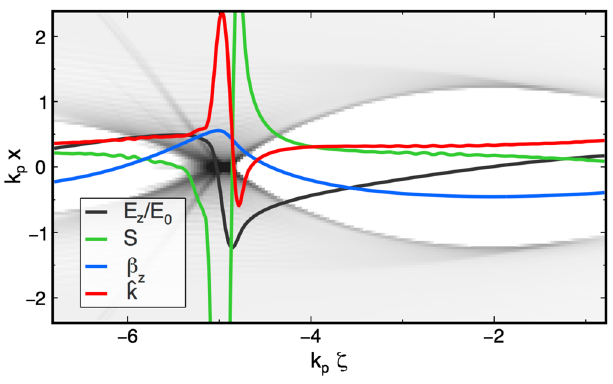
12. Plasma electron density in the blowout regime from a PIC simulation with a 2.5 kA electron driver (grey scale). The (normalized) longitudinal electric field E z =E 0 (black), its nor- malized derivative S (green), the longitudinal velocity of the plasma electrons β z (blue), and the normalized focusing strength ˆ k over the electrons